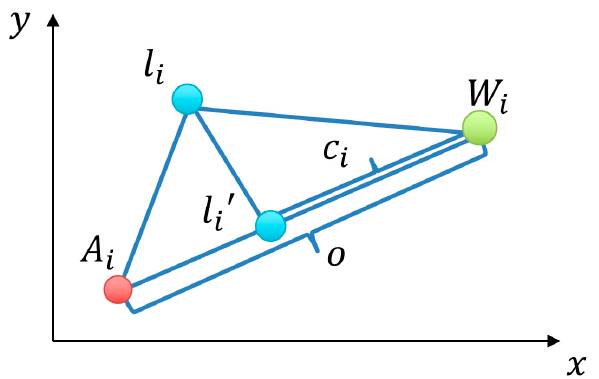
Figure 3. Visualization of the distance of the orthogonal projection of the point 𝑙 (cid:3036)(cid:4593) on the straight line defining the pattern.